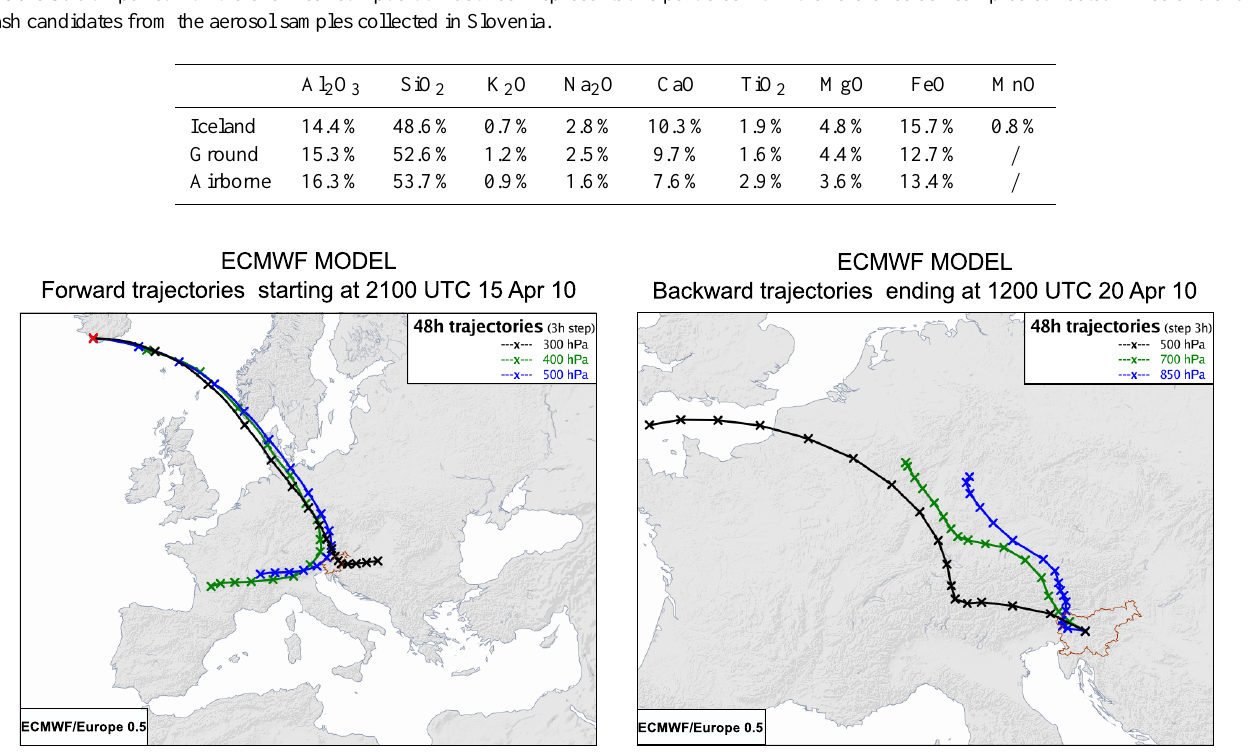
Fig. 12. Air flow trajectories for a 48-h time interval with 3-h temporal resolution obtained from the ECMWF model. Left: forward trajectories for air masses originating near the Eyjafjallajökull volcano starting on 15 April 2010 at 21:00 UTC; Right: backward trajectories of air masses reaching Ljubljana on 20 April 2010 at 12:00 UTC.